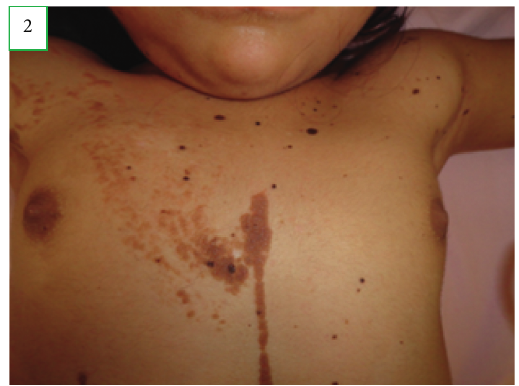
Figure 2: Breast